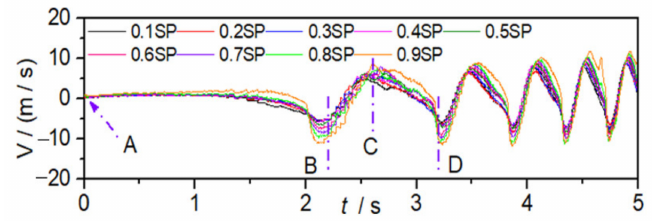
Figure 13. Radial velocity at the runner inlet during t = 0–5 s.